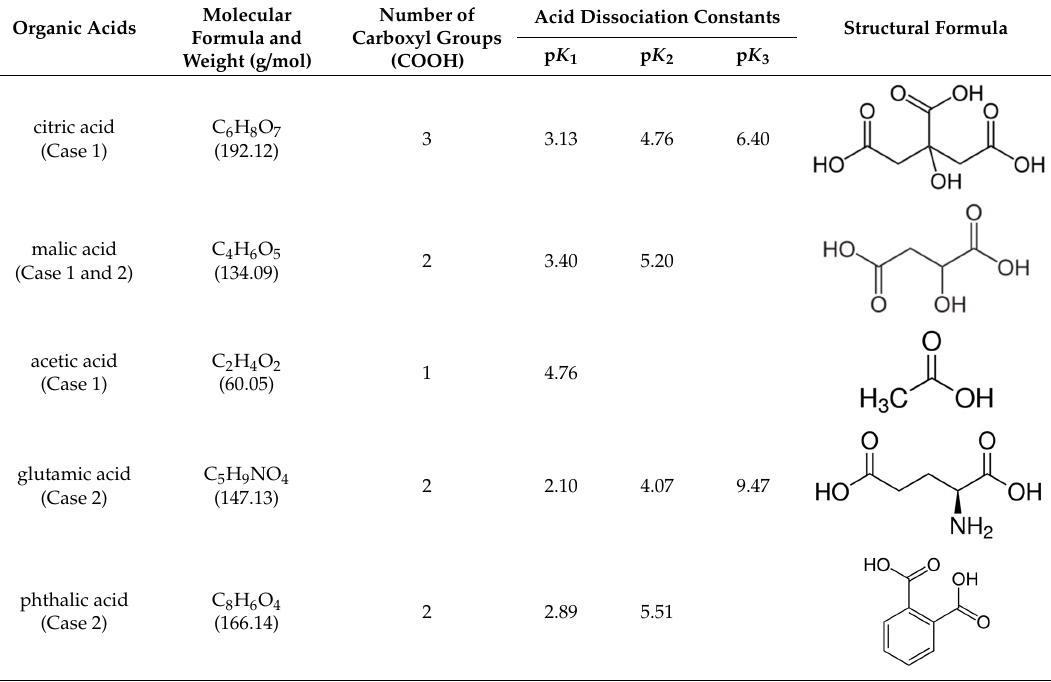
Table 1. Characteristics of the organic acids used in this study.